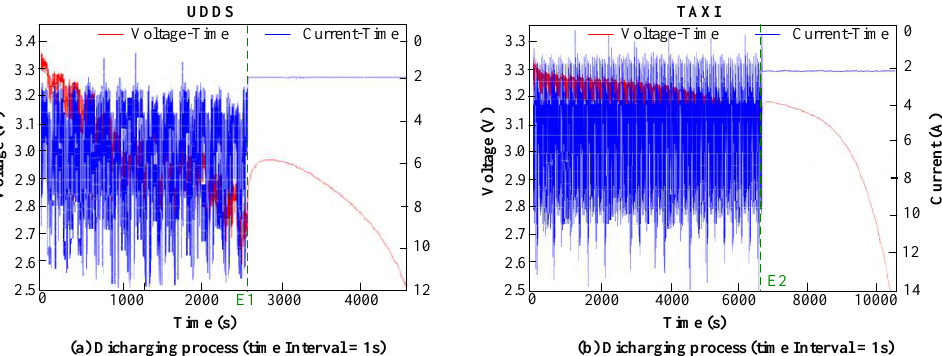
Figure 8. Two different discharging procedures ( a ) UDDS; ( b ) TAXI.